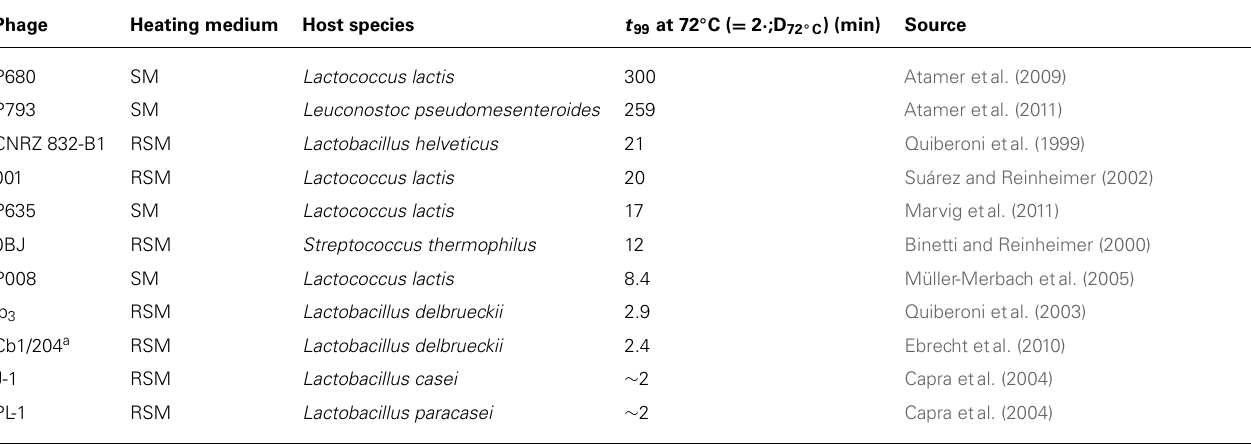
Table 1 |Thermal resistance of bacteriophages infecting lactic acid bacteria.